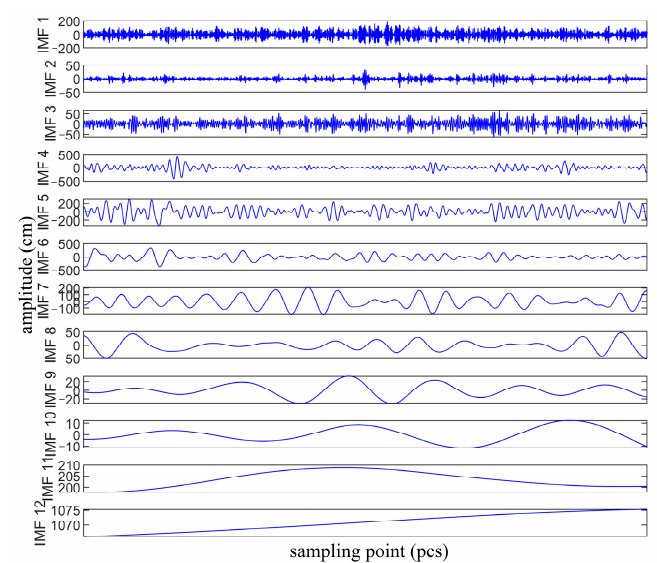
Figure 10. IMFs of actual micro-seismic data.